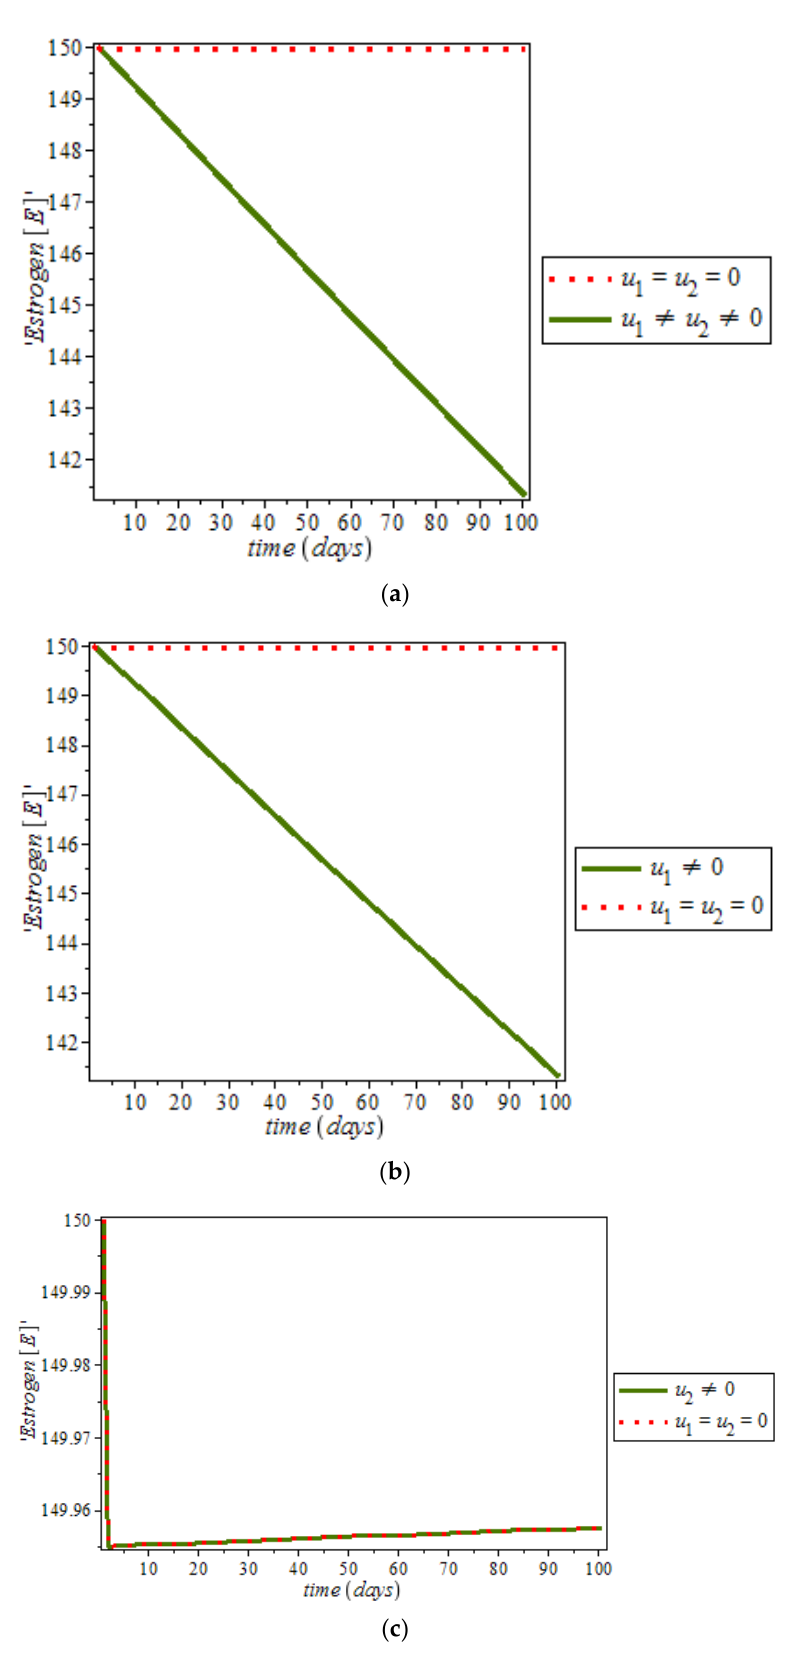
Figure 12. Simulation result of the model (9), showing estrogen level against time with and without control